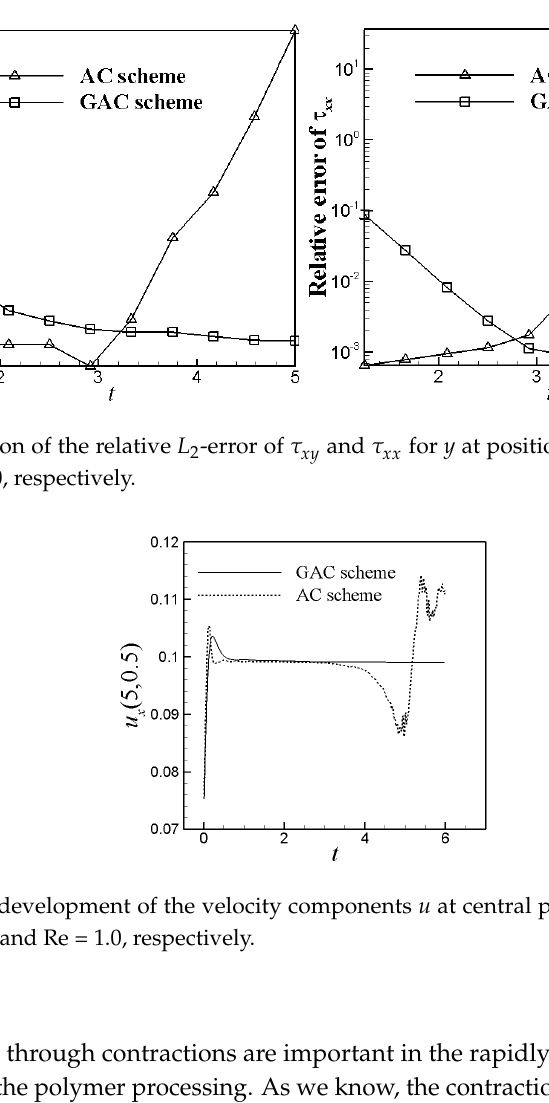
Figure 5. The time development of the velocity components u at central point (5, 0.5) for Wi = 15.0 (right) with β = 0.5 and Re = 1.0, respectively.